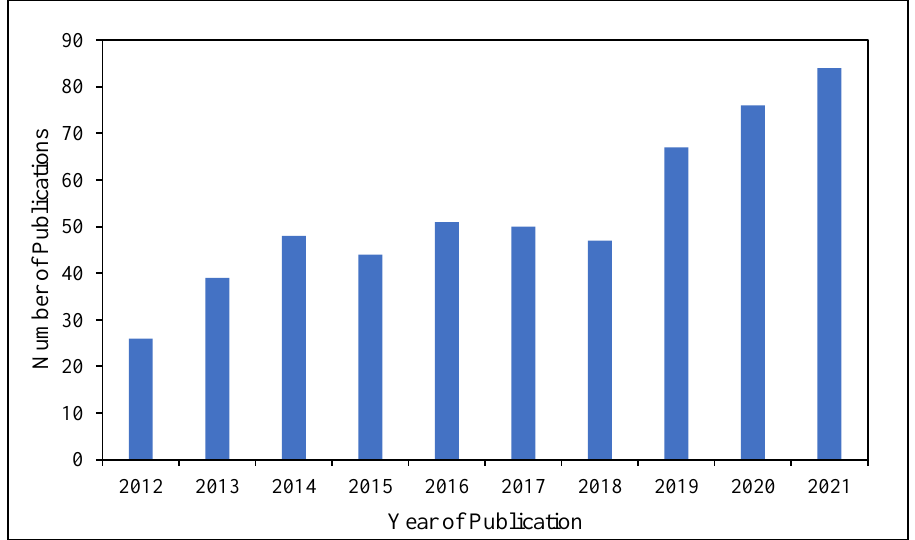
Figure 6. Number of publications regarding applications of PANI in the food industry from 2012 to 2021.